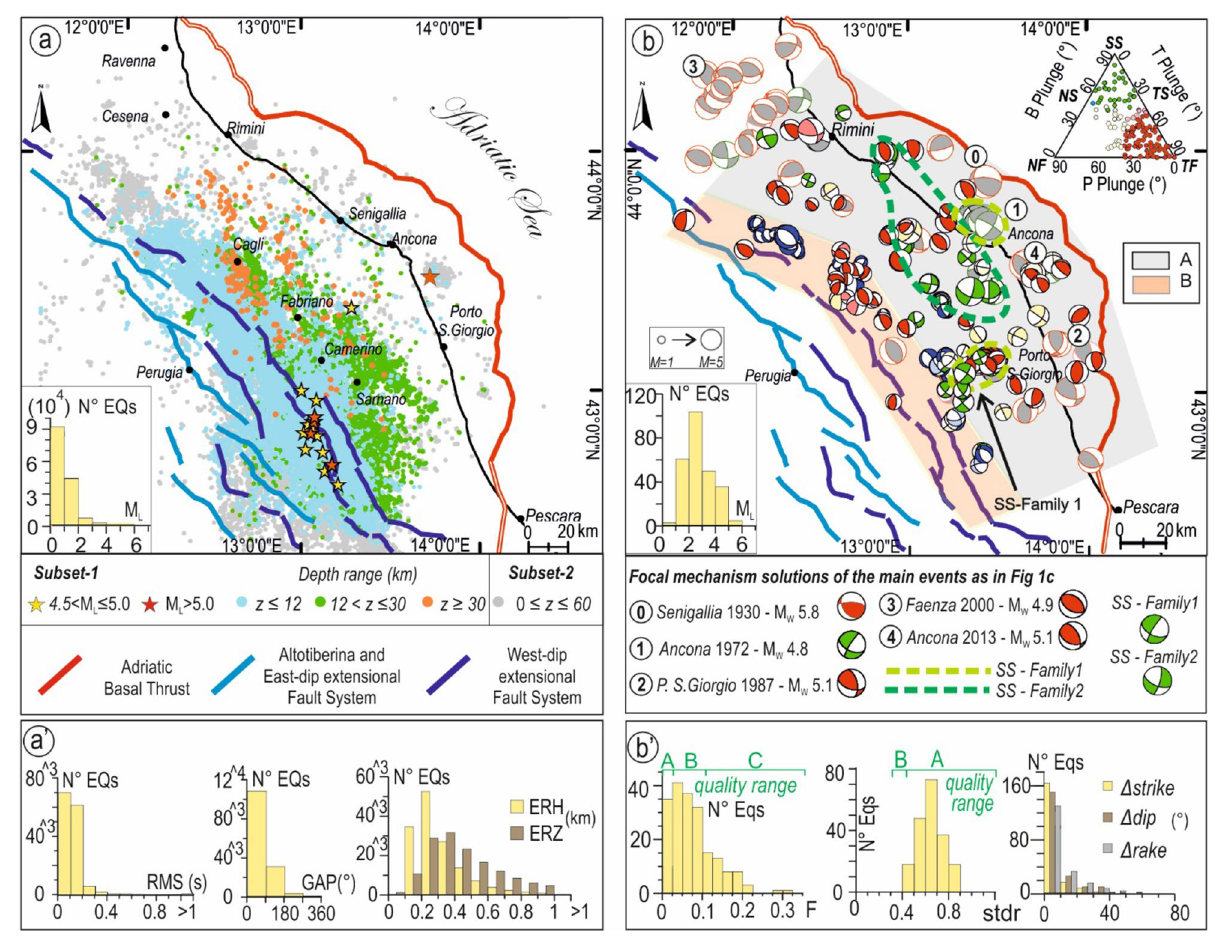
Figure 2. Map view of the earthquakes and focal mechanisms computed and used for this study (EQS- and FMS-Catalogs) (Generic Mapping Tools, GMT 6.4.0, https:// www. gener ic- mappi ng- tools. org/). ( a ) Relocated earthquakes occurred in eastern Central Italy from 2009 to 2017 (0.0 ≤ M L ≤ 5.8) calculated using the recordings of the ReSIICO seismic network and a 3D velocity model 33 . The colored and grey dots represent the higher- quality (Subset-1, EQS-Catalog_HQ.txt in supplementary material) and the lower-quality (Subset-2, EQS- Catalog_LQ.txt in supplementary material) subsets, respectively, as described in the text and supplementary material; the bottom-left inset represents the histogram of the magnitude distribution. ( a ′ ) Histograms of the summary of quality parameters of Subset-1. Key: RMS = root mean square of residuals of the final location, GAP = maximum azimuthal gap, ERH = maximum horizontal error, ERZ = maximum vertical error. ( b ) New (colored beachballs with black border) and collected (grey beachballs with red border) fault plane solutions scaled with magnitude and their respective kinematics classification 41 (triangular diagram in the top right corner). The beachballs color code is red for reverse/reverse-oblique faults, blue for normal/normal oblique faults, green for strike-slip faults and light yellow for unknown kinematics. A and B represent the polygonal areas used to select FMs within different depth ranges (A from 0 to 70 km, B from 12 to 70 km, see detail in “FMS-Catalog” and Supplementary Fig. S9). The dashed light and dark green lines indicate the areas where we observe strike-slip solutions with different P-axis orientations. The bottom-left inset represents the histogram of the magnitude distribution of the new focal mechanisms. ( b ′ ) Histograms of the quality parameters F, stdr, ∆strike, ∆dip, and ∆rake as given in FPFIT code 40